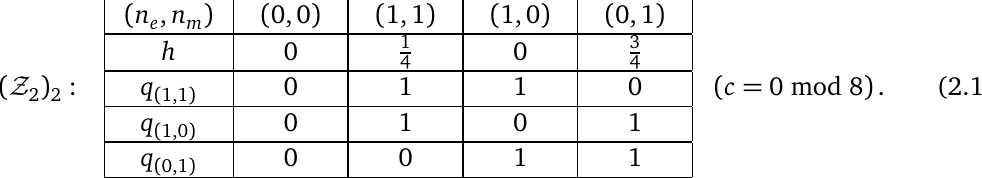
are again given by 1